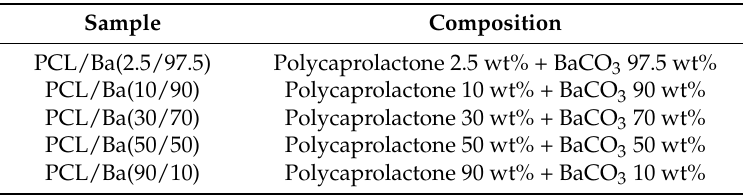
Table 1. Various PCL/Ba media